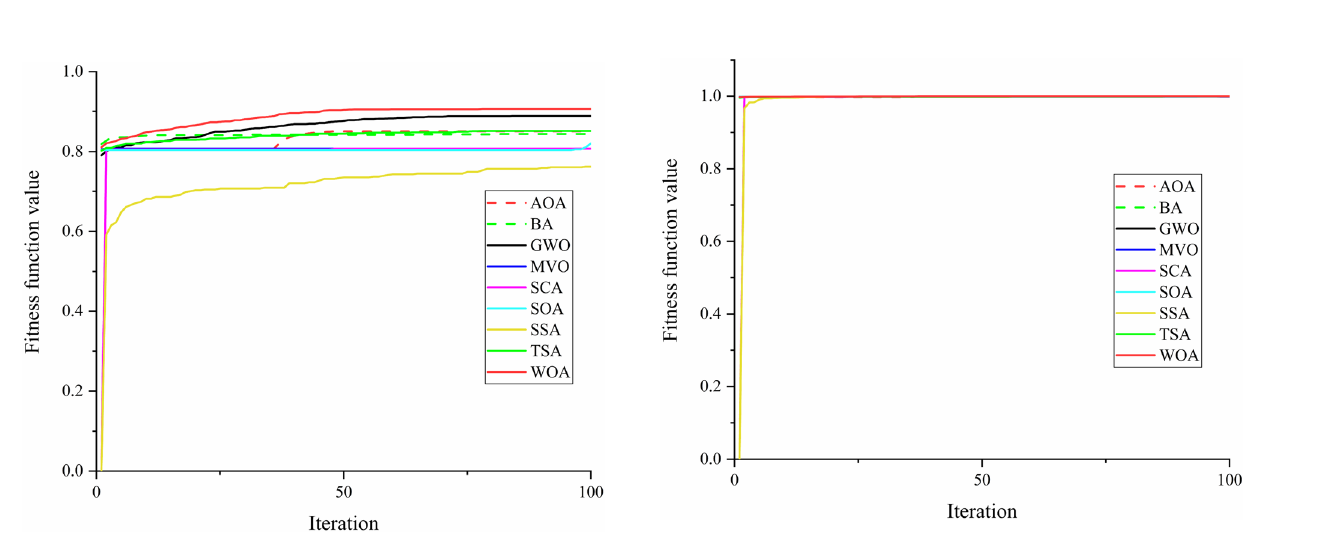
Fig. 7 The evolution curves of the algorithms for case 1